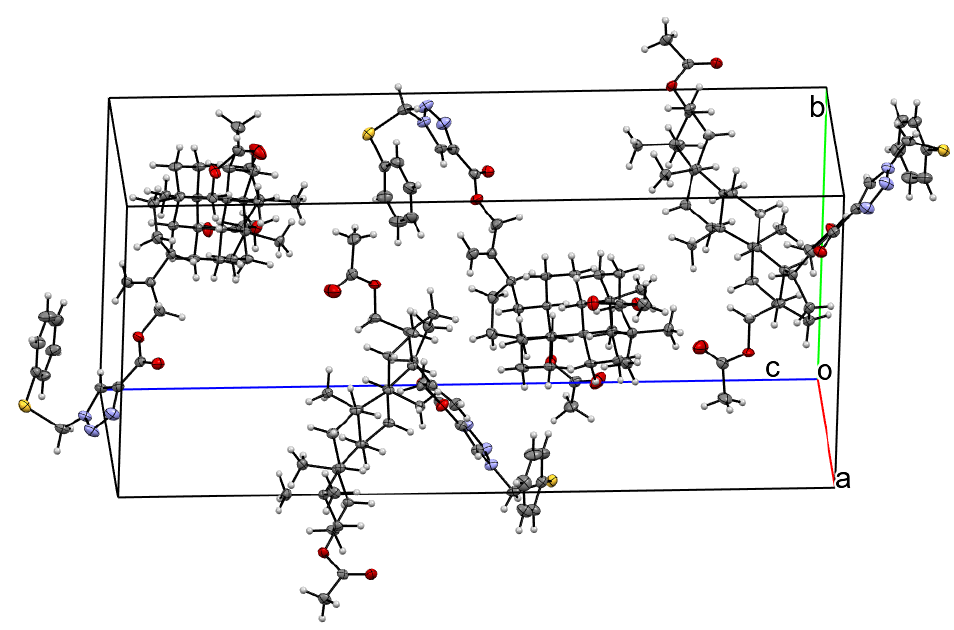
Figure 3. Molecular packing of unit cell for 4 .